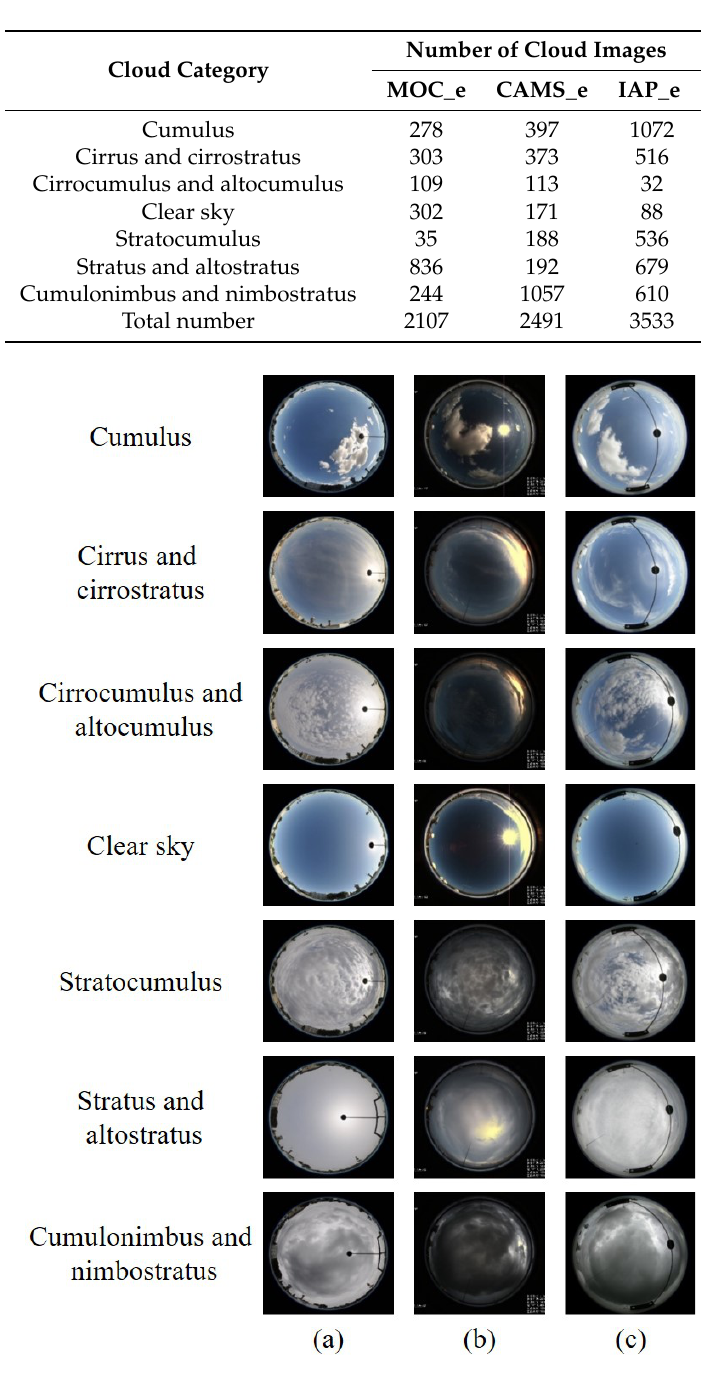
Table 2. The sample number in each category of three datasets.